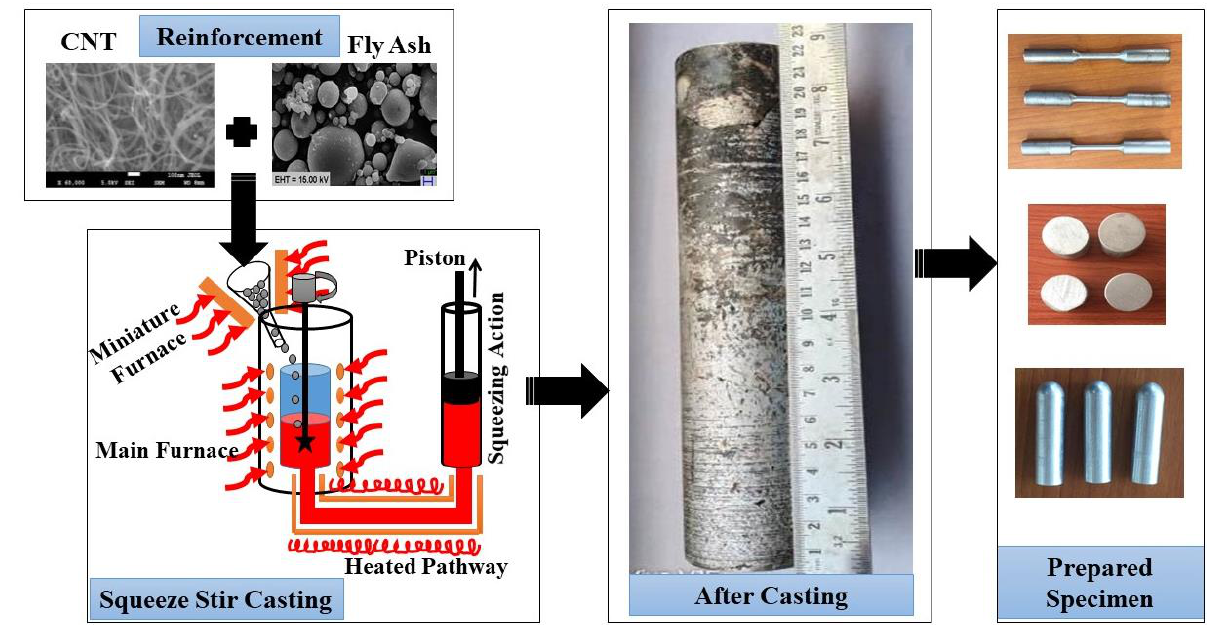
Figure 2. Process flow diagram for the composite fabrication.